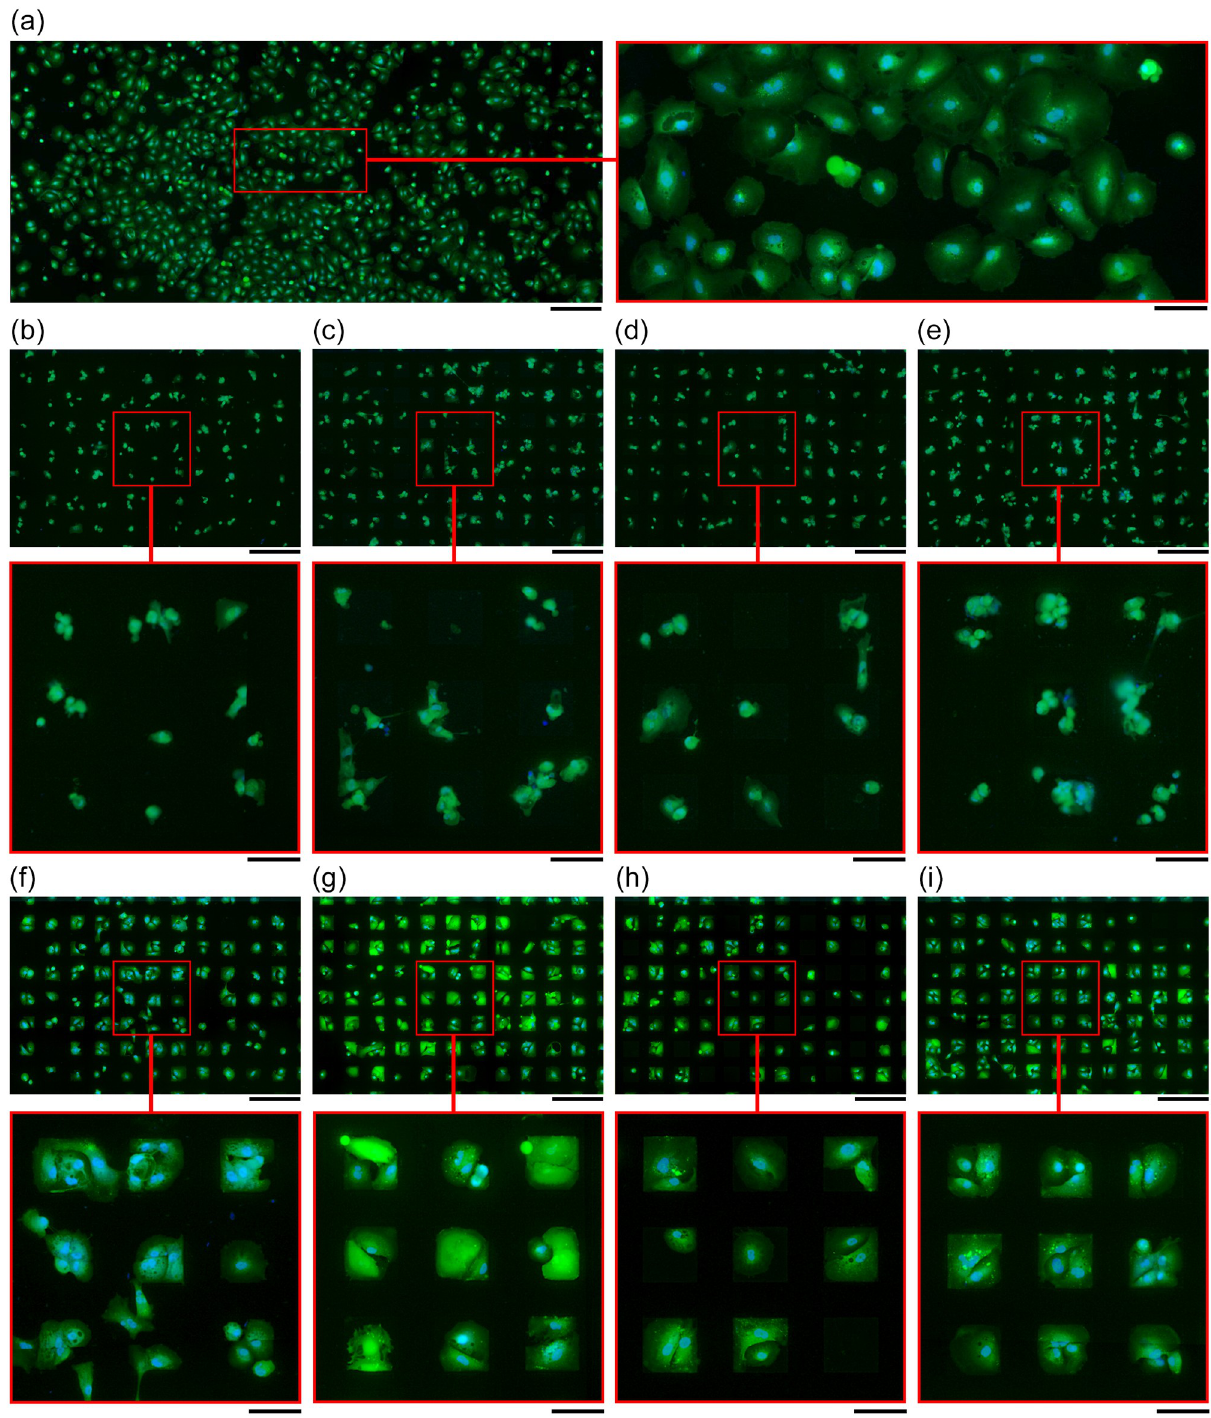
Fig 4. The effect of piranha acid treatment on astrocyte patterning on parylene/SiO 2 substrates. (a) Typical morphology of hNT astrocyte in non- patterned culture. (b-e) Cell patterning on substrates prepared without the piranha acid treatment. (f-i) Cell patterning on substrates prepared with the piranha acid treatment. (b, f) Parylene-HT, (c, g) Parylene-D, (d, h) Parylene-N and (e, i) Parylene-C. Astrocyte cytoplasms were labelled with CMFDA (Green) and the nuclei with Hoechst 33258 (Blue). Overview scale-bar = 500 μ m. Magnified scale-bar = 300 μ m.